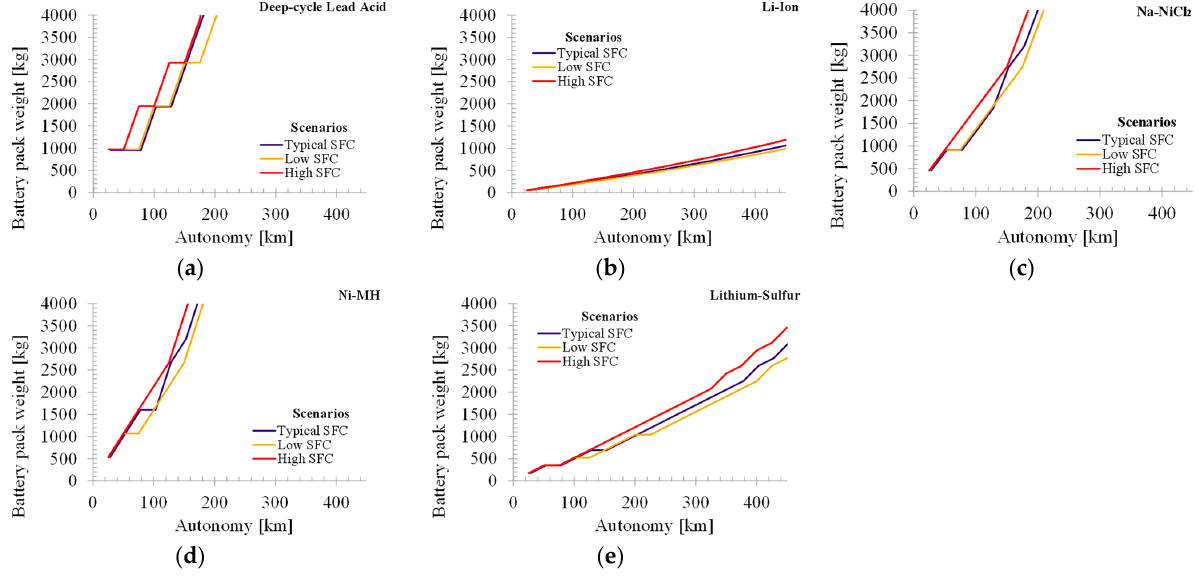
Figure A4. Impact of the desired minimum autonomy on the battery pack weight required consid- ering ( a ) deep-cycle Lead Acid, ( b ) Li-Ion, ( c ) Na-NiCl 2 , ( d ) Ni-MH, and ( e ) lithium-sulfur batteries for low SFC, typical SFC, and high SFC scenarios.